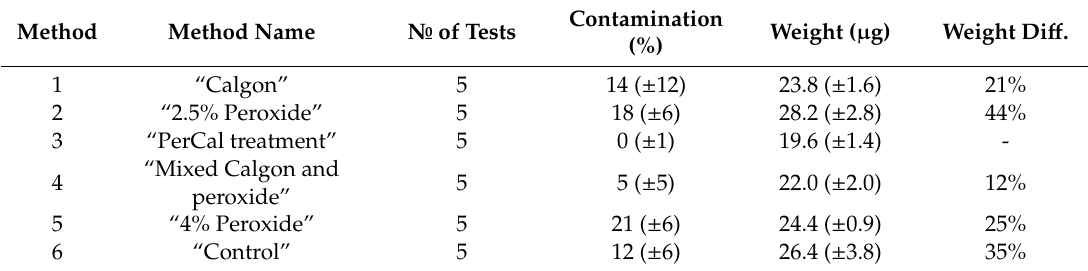
Table 2. Table showing the results of the X-ray tomographic and weight analyses. The degree of contamination is given as a percentage of cell’s volume. Furthermore, the difference in the measured weights in regard to the average shell weight of the least contaminated tests.